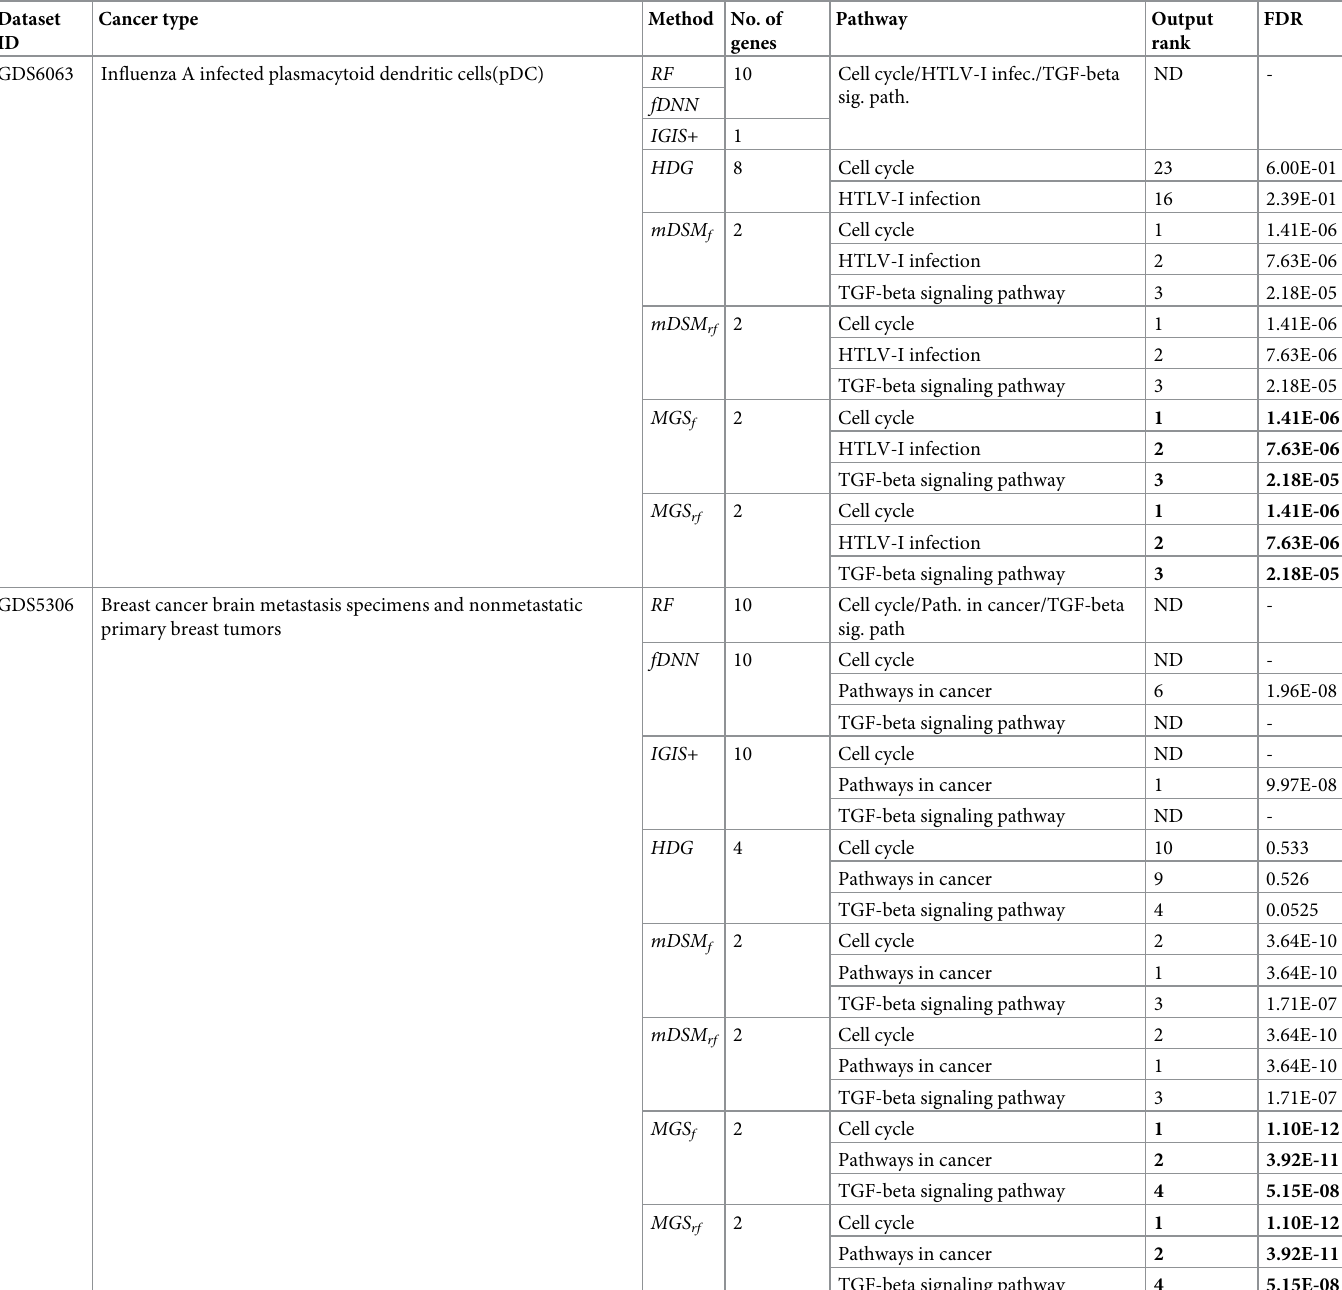
Table 5. Comparative performance of different methods in identification of relevant biological pathways for balanced